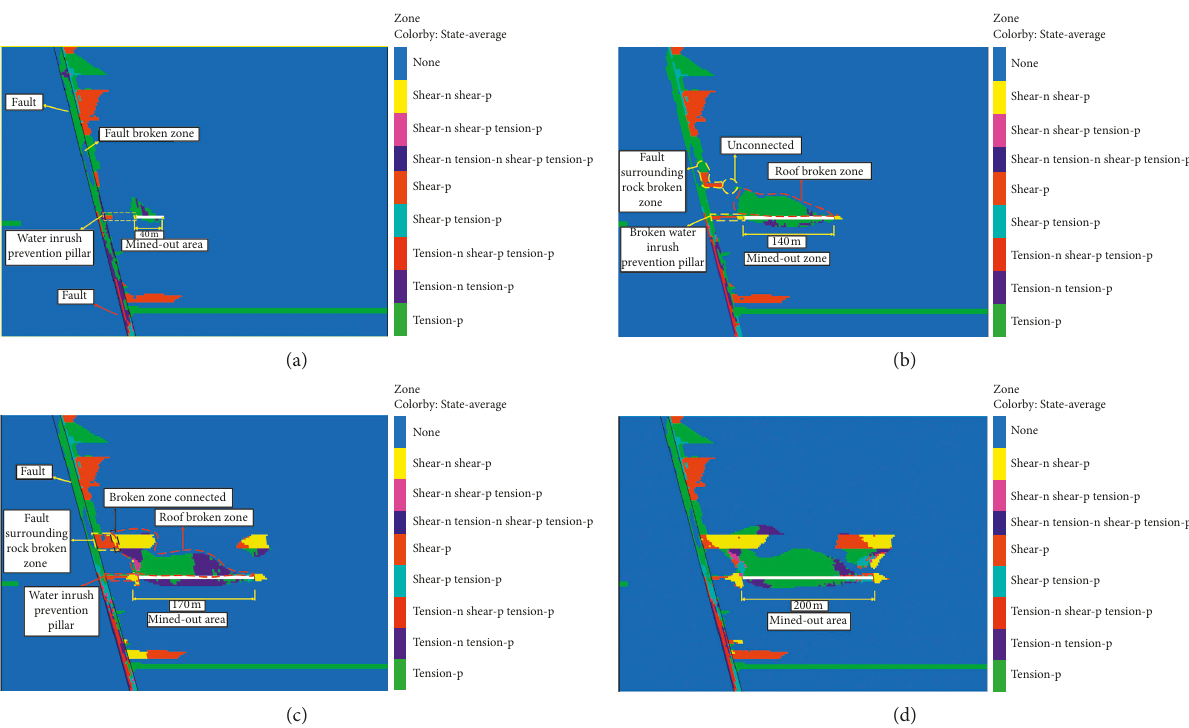
Figure 8: The evolution laws of broken zone caused by mining.